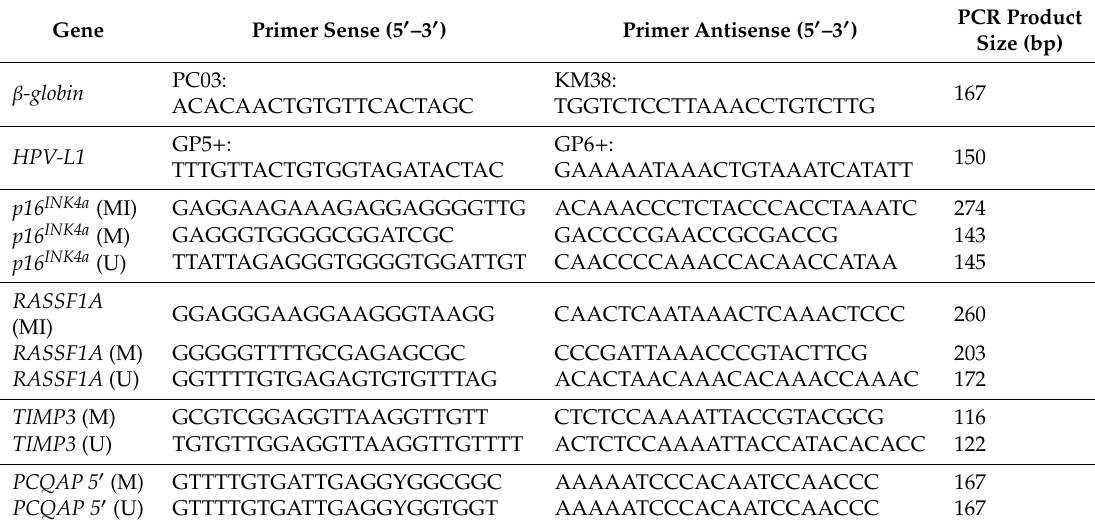
Table 1. Primer sequences used in the